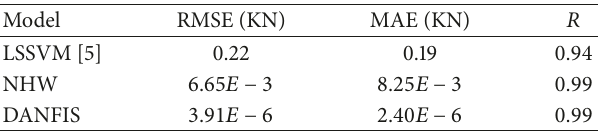
Table 5: Comparison between the developed models and the LSSVM [5] model for the training